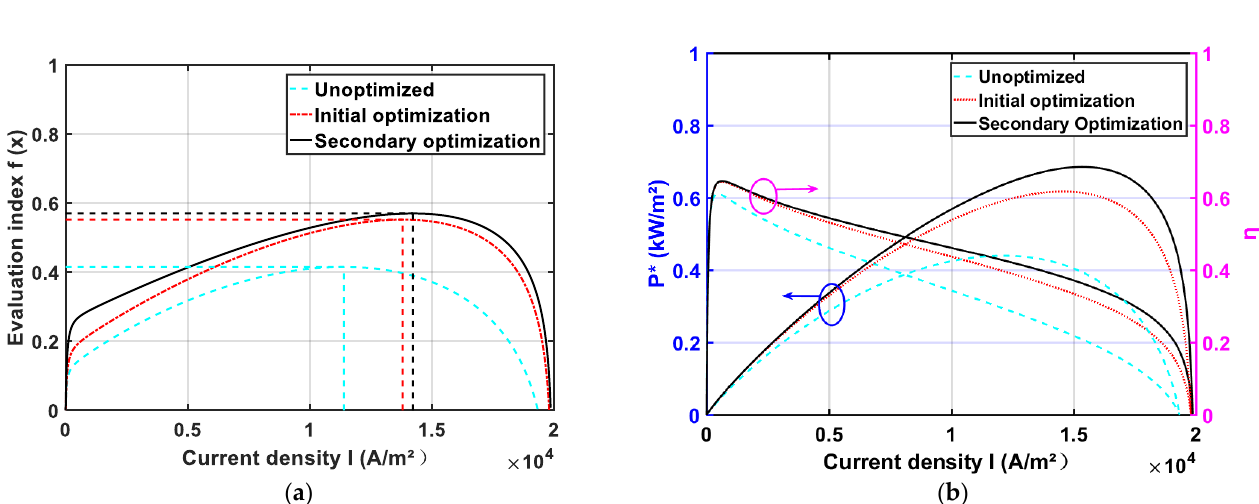
Figure 5. Comparison of optimization results: ( a ) 𝑓(𝑥) ; ( b ) 𝑃 ∗ , and 𝜂 .